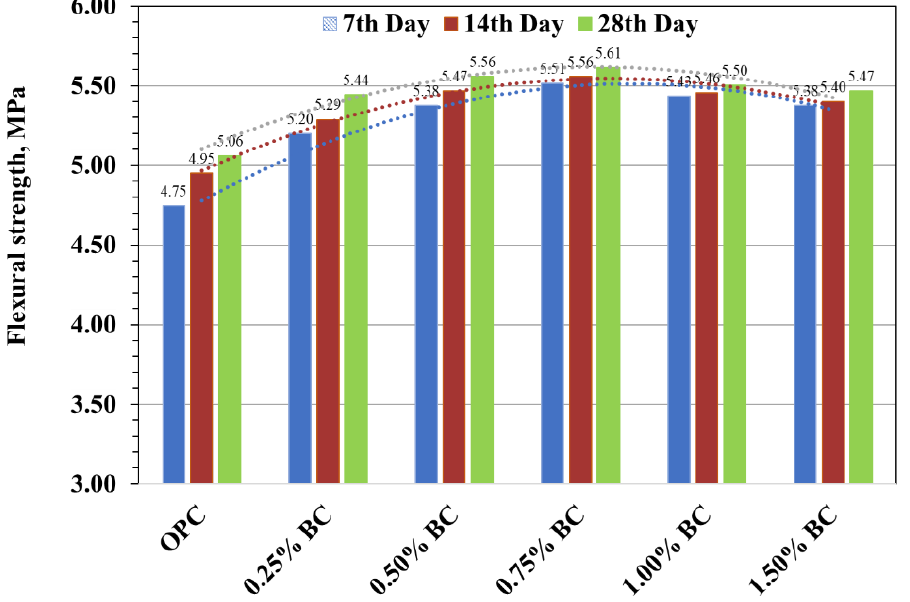
Figure 7. Flexural strength of concrete beam specimens.